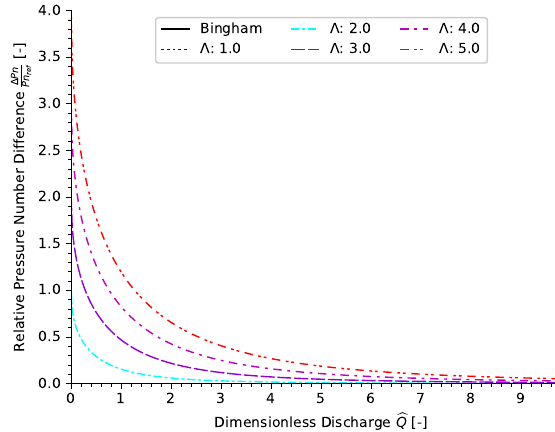
Figure 9: The pressure number Pn is numerically inverted from Eq. (25) and the relative difference with the Bingham-Reiner equa- tion ( Pn ref ) is plotted as a function of dimensionless discharge ̂︀ Q